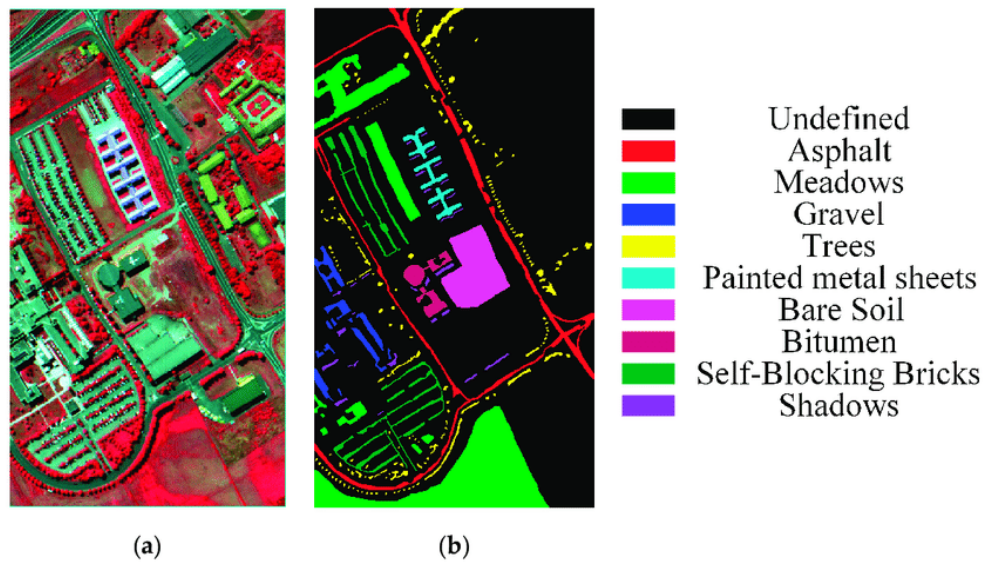
Figure 3. Pavia Hyperspectral Images Dataset ( a ) Segmented Image; ( b ) Ground truth labelled image.